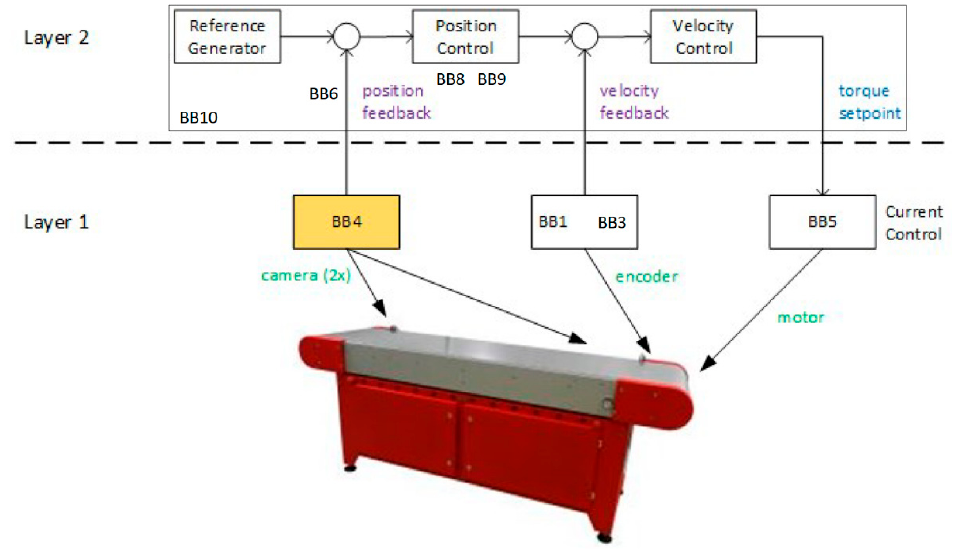
Figure 9. Pilot 1 = GSC overall control system structure and utilization of BBs.